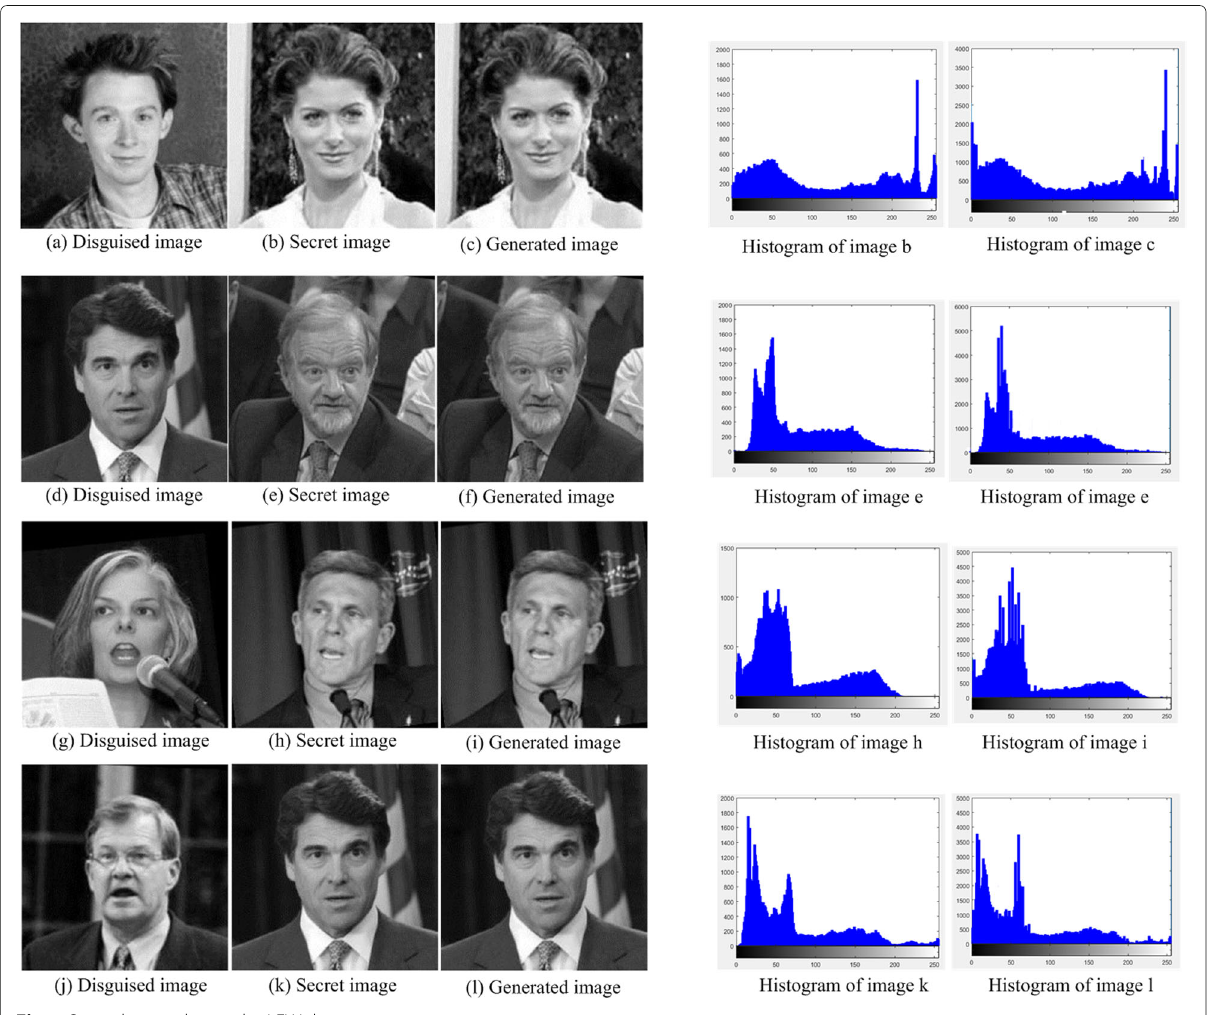
Fig. 7 Several examples on the LFW dataset